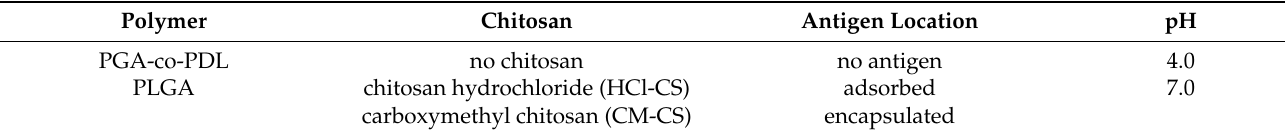
Table 2. Factors investigated for NP